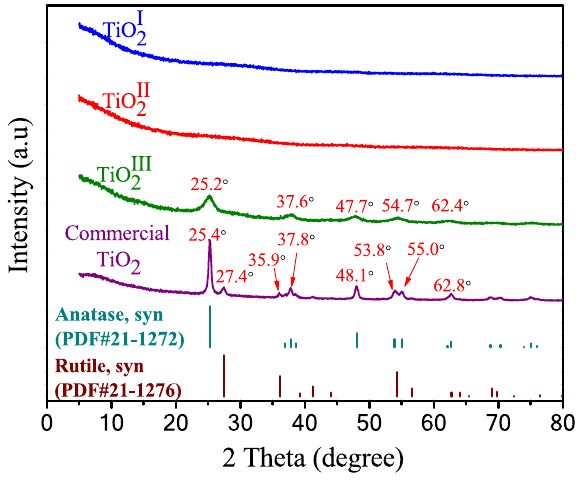
Figure 1. XRD patterns of synthesized and commercial TiO 2 .